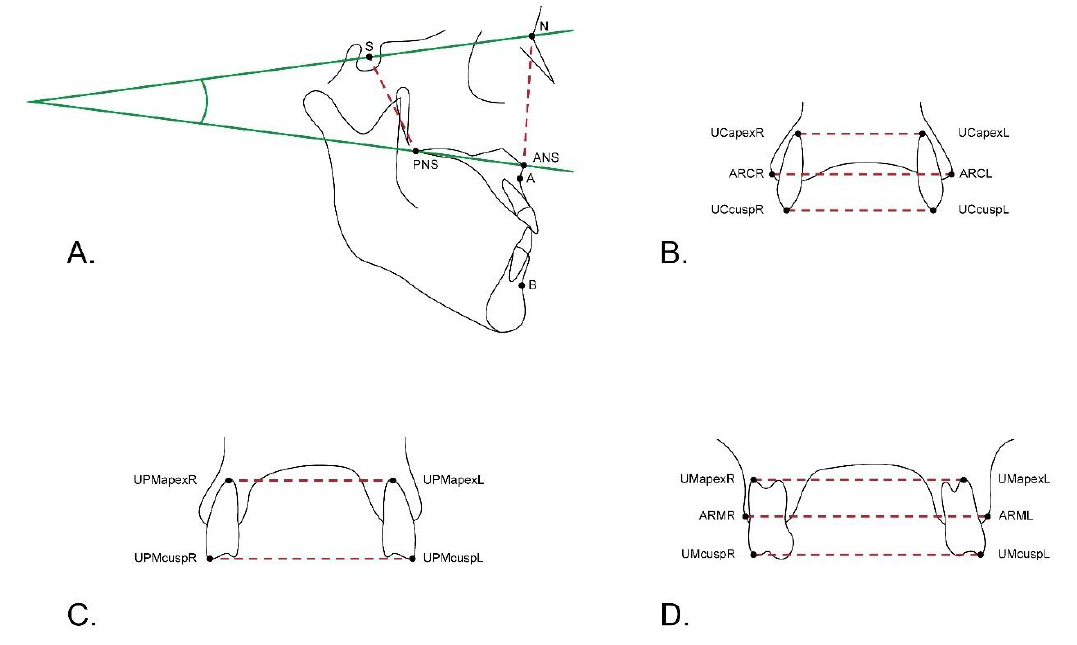
Figure 1. Schematic representation of the reference points and linear measurements (dashed lines) used in the study. ( A )—sagittal landmarks and measurements, ( B – D )—frontal landmarks and measurements. Legend. ARM : the most inferior and lateral point of the maxillary alveolar ridge at the first molar level; ARC : the most inferior and lateral point of the maxillary alveolar ridge at the canine level; UMcusp : the most inferior point of the mesial cusp of the first upper molar; UPMcusp : the most inferior point of the buccal cusp of the first upper premolar; UCcusp : the most inferior point of the upper canine cusp; UMapex : the most superior point of the mesiobuccal root of the first upper molar; UPMapex : the most superior point of the buccal root of the first upper premolar; UCapex : the most superior point of the upper canine root; N : the midpoint of the frontonasal suture (nasion); S : the center of the hypophyseal fossa (sella turcica, sella); ANS : the most anterior midpoint of the anterior nasal spine of the maxilla; PNS : the most posterior midpoint of the posterior nasal spine of